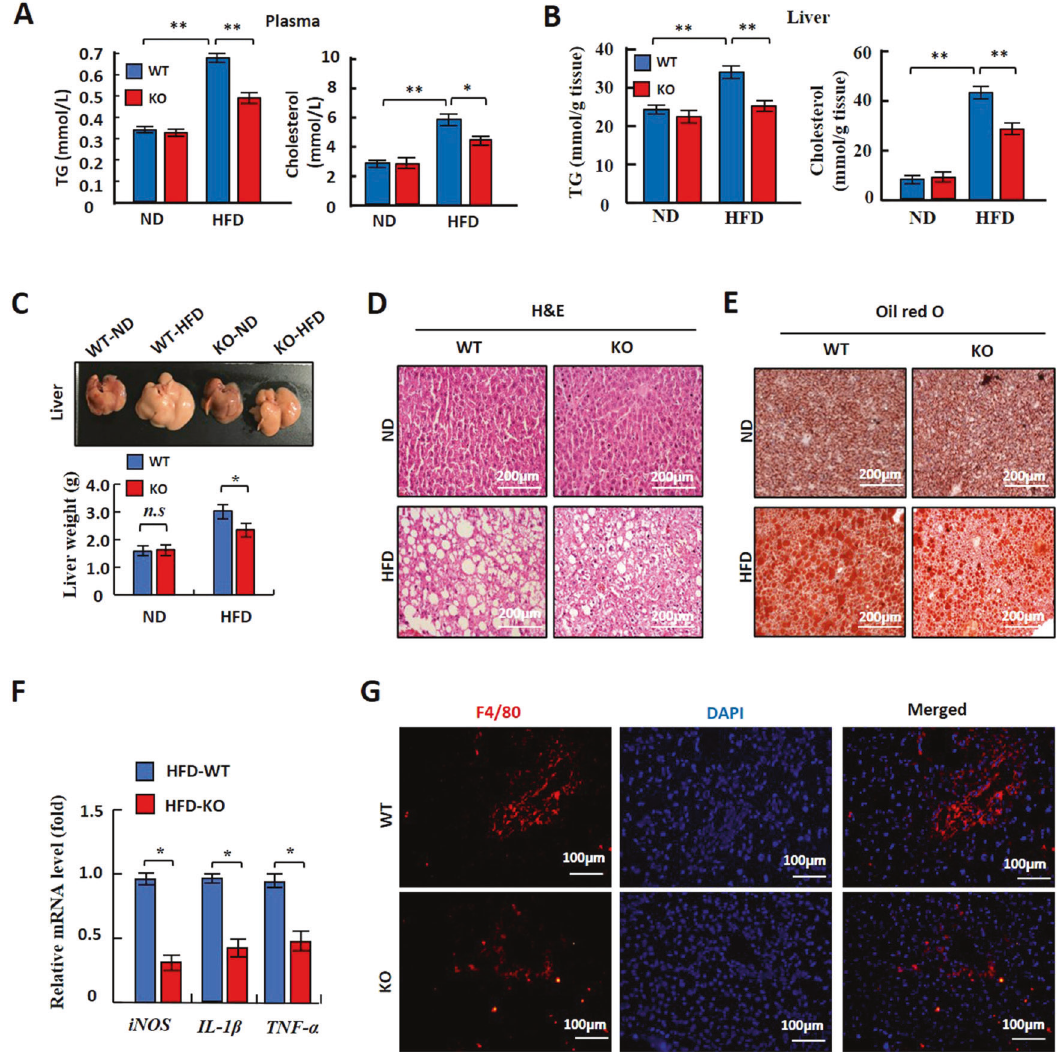
Fig. 7 LXN-de fi cient mice are resistant to HFD-induced hepatic steatosis. A , B Results for TG and cholesterol levels in plasma ( A ) and liver ( B ) of WT and LXN -/- mice fed a ND or HFD for 23 weeks ( n = 8). C Comparison of liver weight. Top: Representative pictures for livers collected from WT and LXN − / − mice. Bottom: Results for liver weight ( n = 8). D , E Representative results for H&E staining ( D ) and Oil Red O staining ( E ) of liver sections. Scale bar = 200 μ m. F Real-time PCR results for analysis of in fl ammation marker genes in liver ( n = 8). G Representative pictures